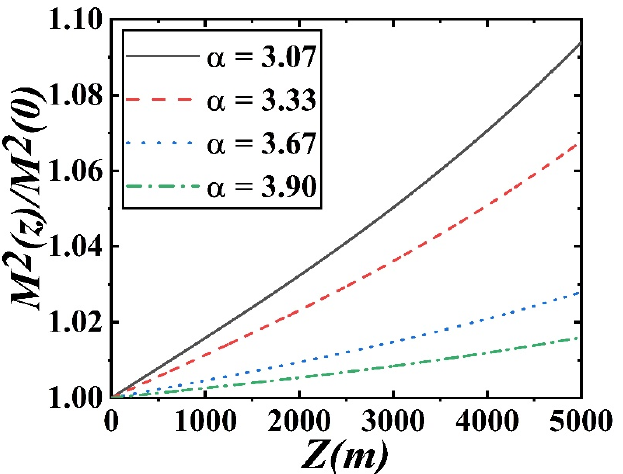
bulence (black, red and green lines in Figure 1) is distinct from that of Kolmogorov turbu ‐ lence (blue line in Figure 1 and ).